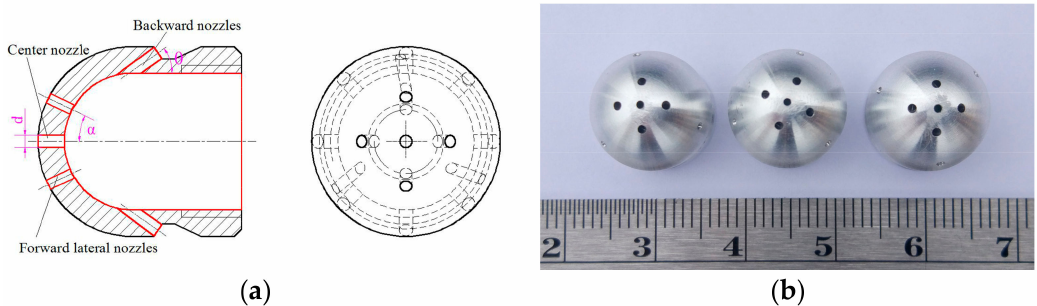
Figure 2. Water-jet bits used in field experiment: ( a ) schematic diagram of nozzle layout in the water-jet bit, and ( b ) physical image of the bits.